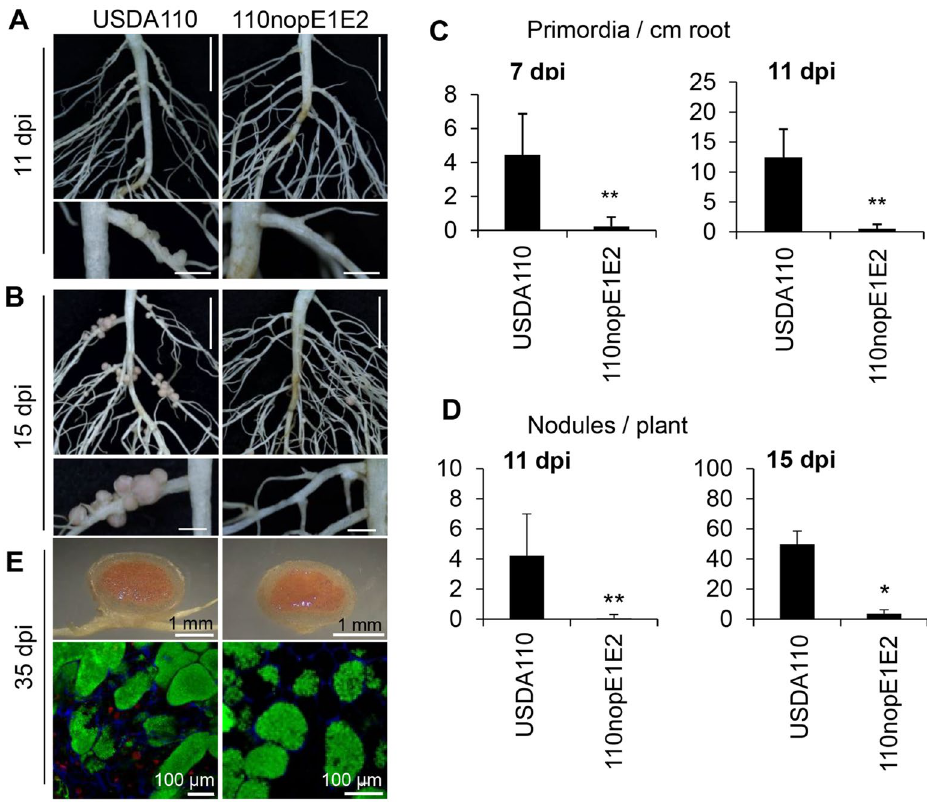
Figure 2. Nodulation properties of V. radiata cv. KPS1 inoculated with B. diazoefficiens strains. The roots were imaged at 11 (A) and 15 (B) dpi. (C) Nodule primordia per centimetre of root tissue and (D) numbers of young nodules per plant observed at 7, 11 and 15 dpi. (E) Nodule morphology and propidium iodide (PI)/SYTO9 staining of sectioned nodules. The data shown are the means of at least 6 plants at 7 and 15 dpi and of 18 plants at 11 dpi. The basal regions of lateral roots were sampled (3 samples per plant, n = 18) for microscopy analyses. Scale bars: 1 cm, entire roots; and 2 mm, nodule primordia and young nodules. “*” P < 0.05 and “**” P < 0.01 according to Student’s t